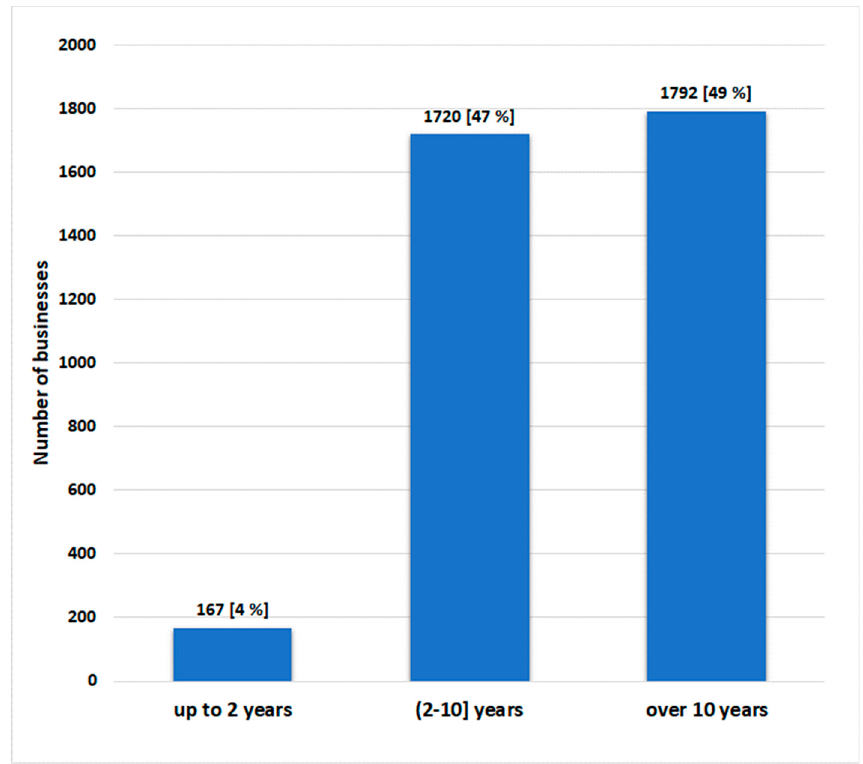
Figure 4. The structure of the number of businesses in the Podkarpackie Voivodeship by the duration of business activity (in years). Source: own elaboration based on the data analyzed from 2018 (http://www.emis.com).